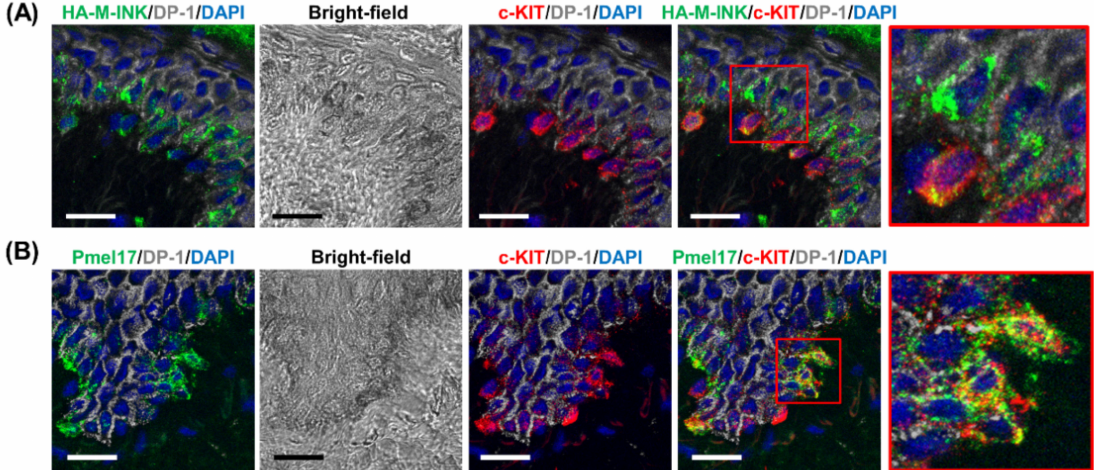
Figure 4. Immunostaining images of HA-M-INK and Pmel in human skin sections. ( A ) Skin section obtained from a phototype IV subject was stained for HA-M-INK (green), c-KIT (melanocyte marker, red), DP-1 (keratinocyte marker, gray), and DAPI (blue). ( B ) The sample was stained for Pmel (premelanosome marker, green), c-KIT, DP-1, and DAPI. The insets are magnified views of the boxed areas. HA-M-INK-positive melanin was observed not only in melanocytes but also in keratinocytes. By contrast, Pmel staining was mainly observed in melanocytes, and only a few signals were present in keratinocytes. Scale bars = 20 µ m.